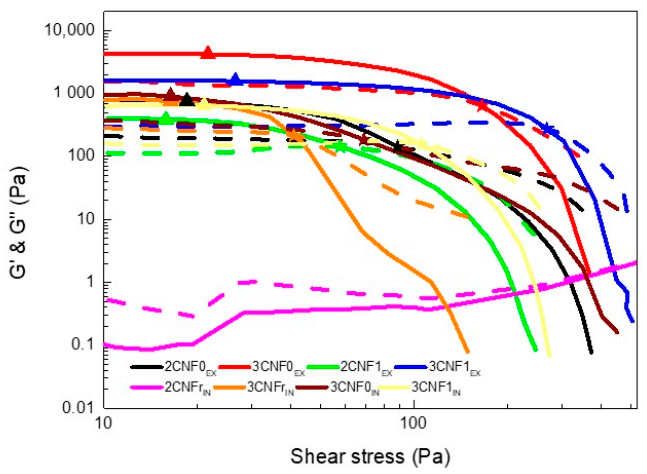
Figure 4. Storage (solid line) and loss (dotted line) moduli as a function of shear stress and ( ▲ ) yield and ( ★ ) flow points of WBPUU/CNF inks. Table 3. Yield and flow point values and structure recovery capacity WBPUU/CNF